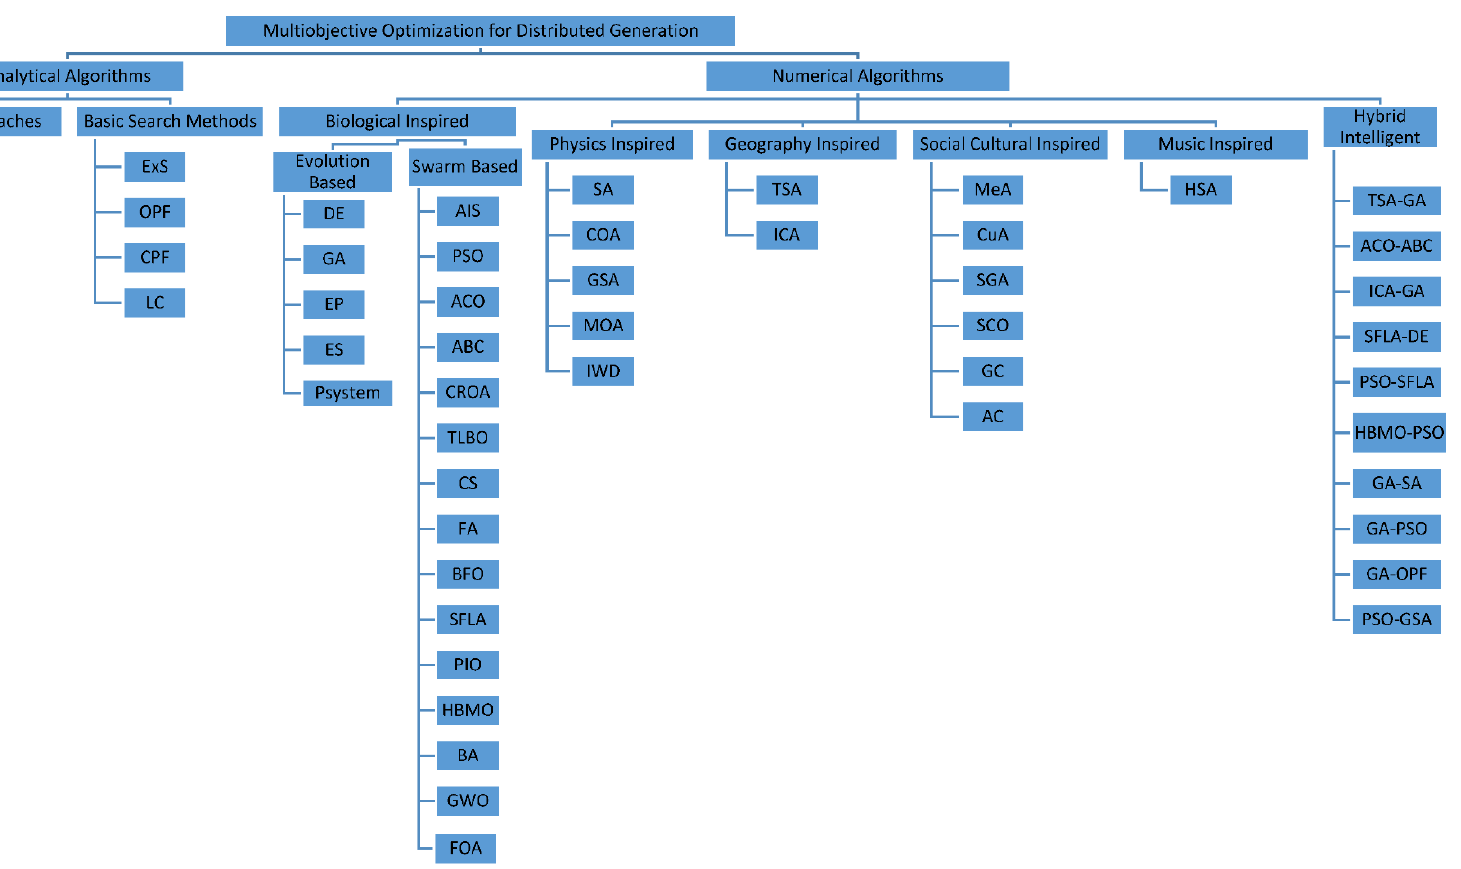
Figure 3. Taxonomy of optimization algorithm used for optimal DG placement problem. Note: Algorithm abbreviations: LP — linear programming, MILP — mixed